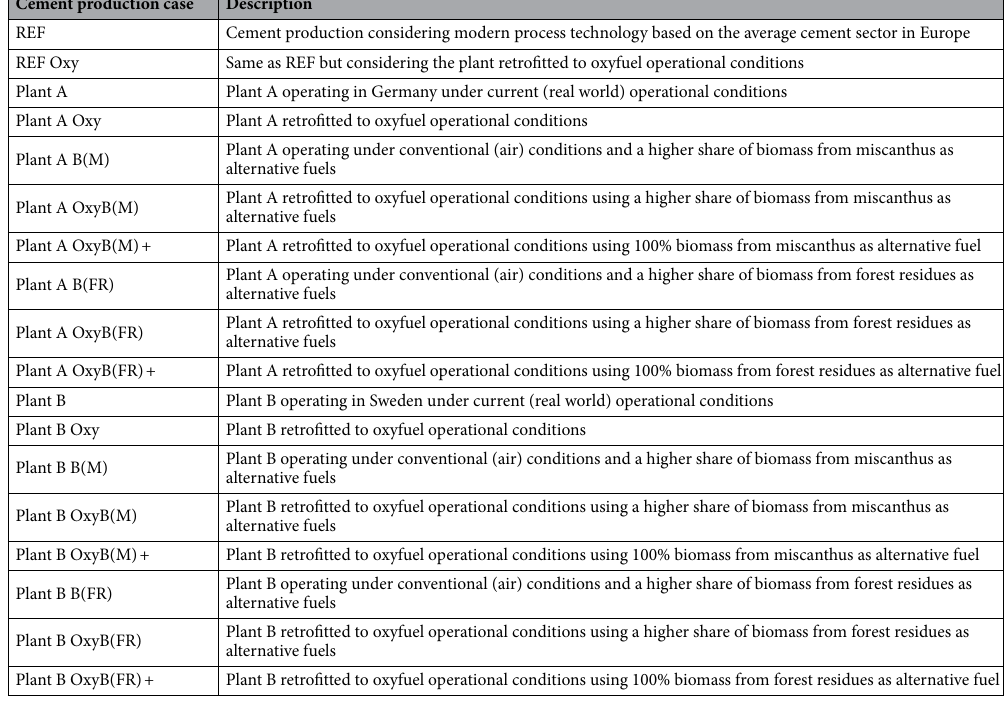
Table 1. Cement production cases considered in this